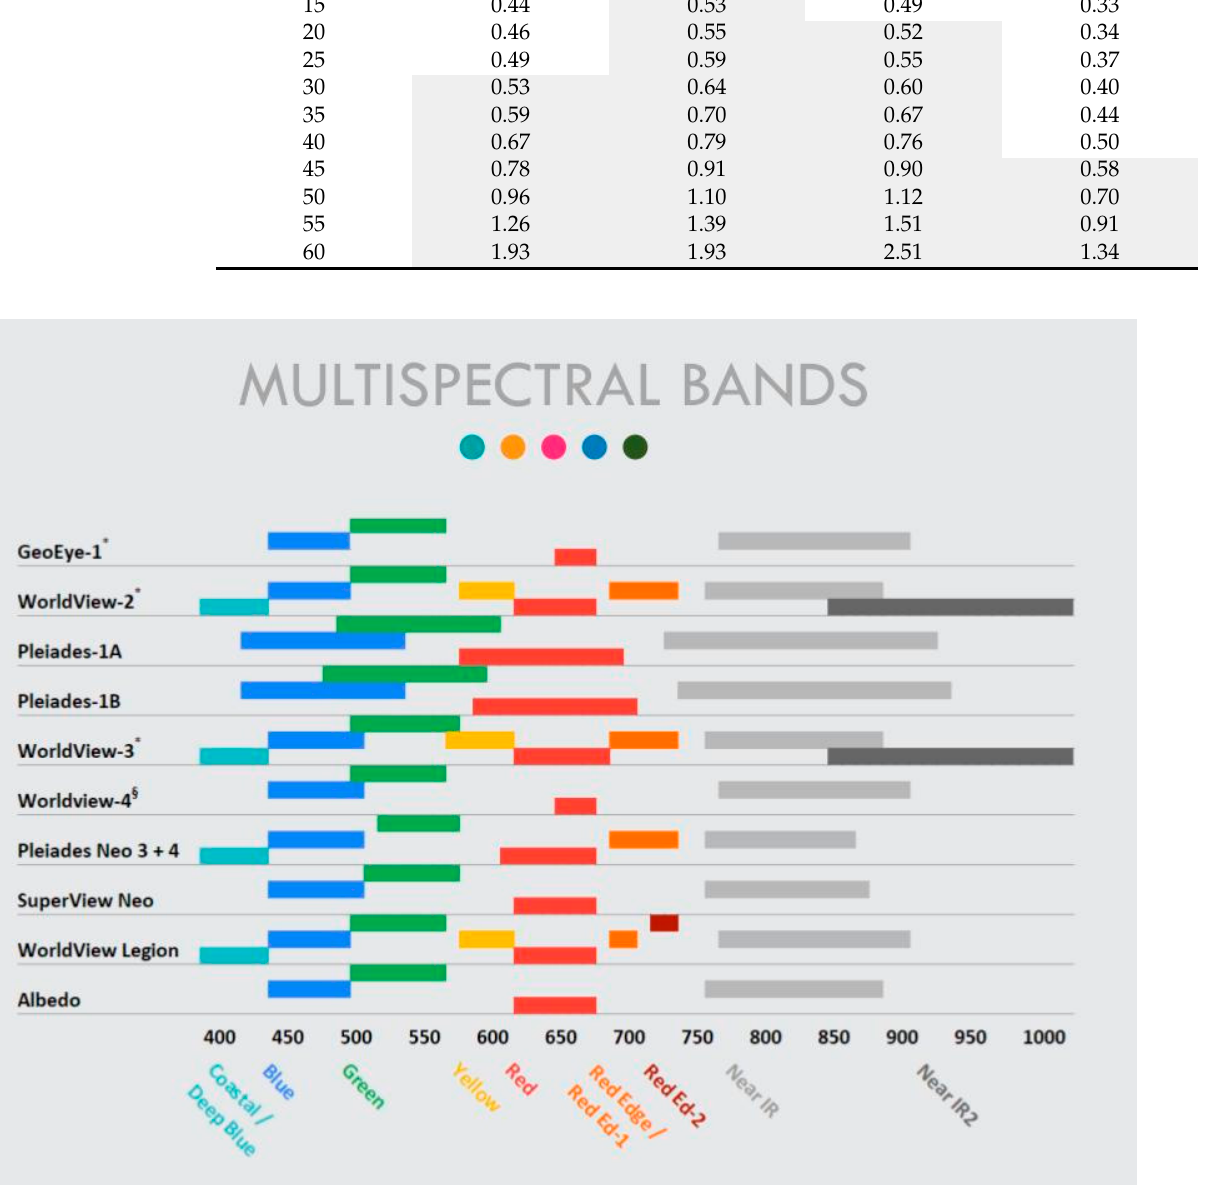
Figure 6. The wavelengths of multispectral band edges for each band given in nanometers found in VHR satellites with image resolution ≤ 0.50 m. * Utilized by Geospatial Artificial Intelligence for Animals (GAIA). § As of early 2019, WorldView-4 is in non-recoverable status and no longer collecting new imagery.